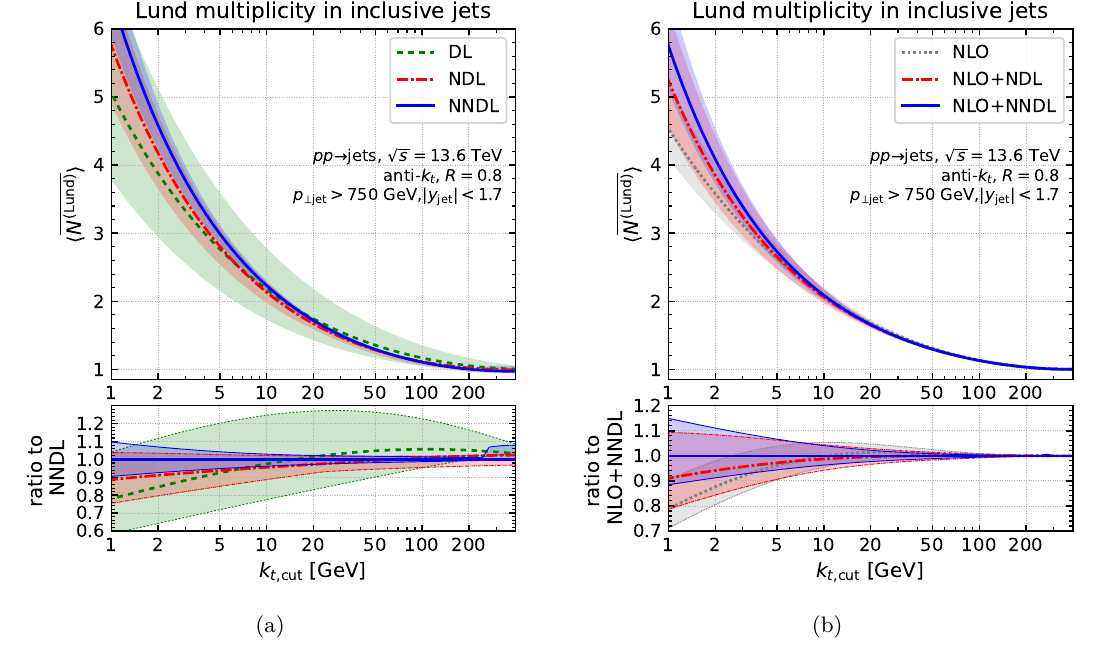
Figure 7 . Left: resummed Lund average multiplicity at DL (dashed, green), NDL (dash-dotted, red) and NNDL (solid, blue) as a function of k for LHC kinematics. Right: average Lund multiplicity t, cut after matching with NLO. The pure NLO result is shown in dotted (grey) for reference, together with matched NLO+NDL (dash-dotted, red) and NLO+NNDL (solid, blue). The bottom panels display the ratio to the most accurate result (NNDL on the left and NLO+NNDL on the right).